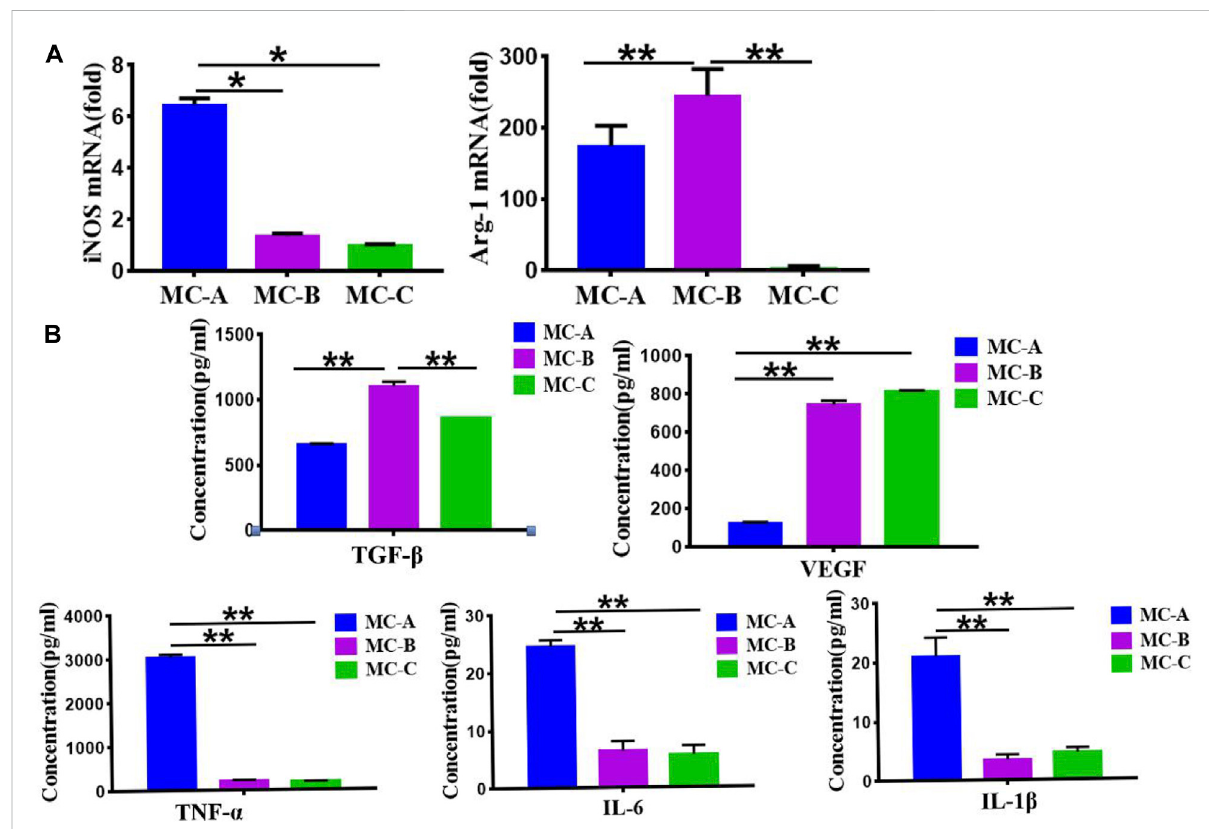
FIGURE 5 Effects of mineralized collagen with different microporous structures on macrophages polarization. (A) Expression of iNOS and Arg-1 marker showing the M1 and M2 polarization of macrophages cultured (M1: iNOS; M2: Arg-1); (B) Secretion of TGF- β , VEGF, and proin fl ammatory cytokines (TNF- α , IL-6, IL-1 β ). Data are presented as mean ± SD. *p < 0.05; **p <